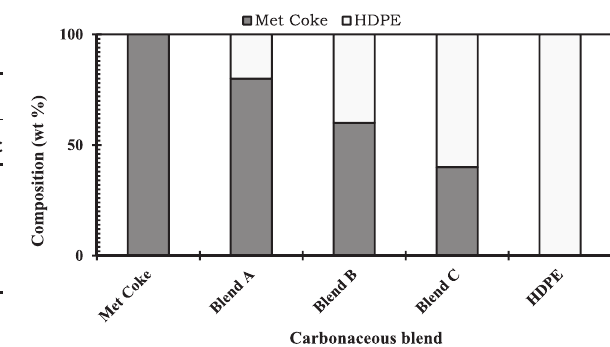
Fig. 1: Blend compositions of the different carbonaceous materials utilised in this study